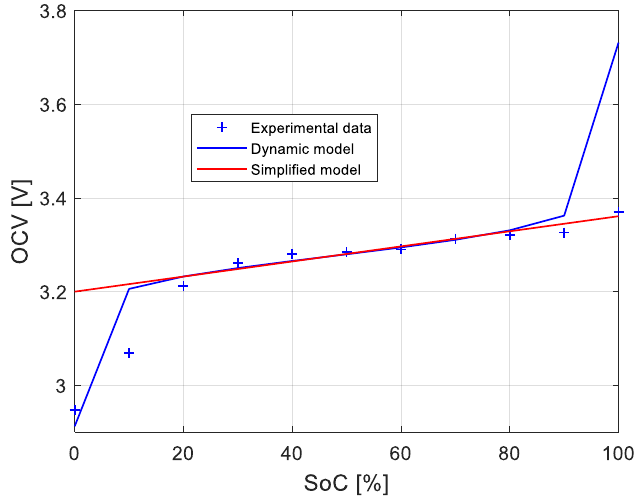
Figure 5. Relationship between battery OCV and